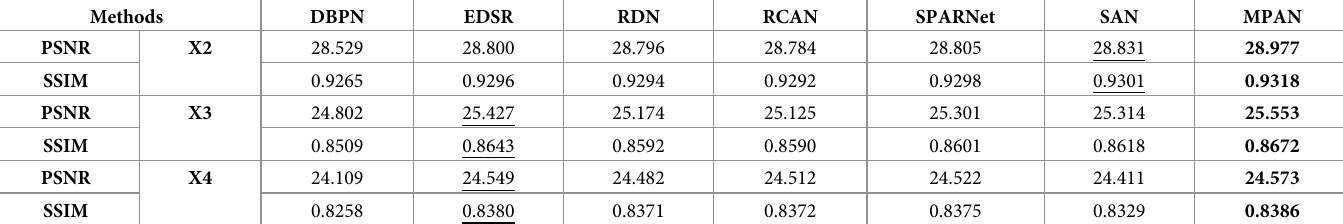
Table 4. Quantitative results with 128x128 output and scale factor of X2, X3 and X4. The top and second-place results are emphasized in bold and underlined, respectively.